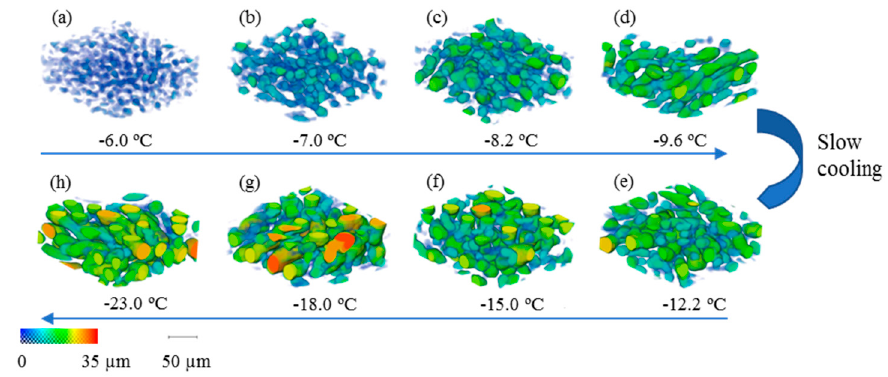
Figure 7. 3D visualisation of ice crystal morphological evolution during the slow cooling experiment: ( a ) − 6 °C, ( b ) − 7.0 °C, ( c ) − 8.2 °C, ( d ) − 9.6 °C, ( e ) − 12.2 °C, ( f ) 15 °C, ( g ) − 18.0 °C and ( h ) − 23.0 °C. Ice crystals are colour–rendered using local thickness. Scale bar is 50 µm.